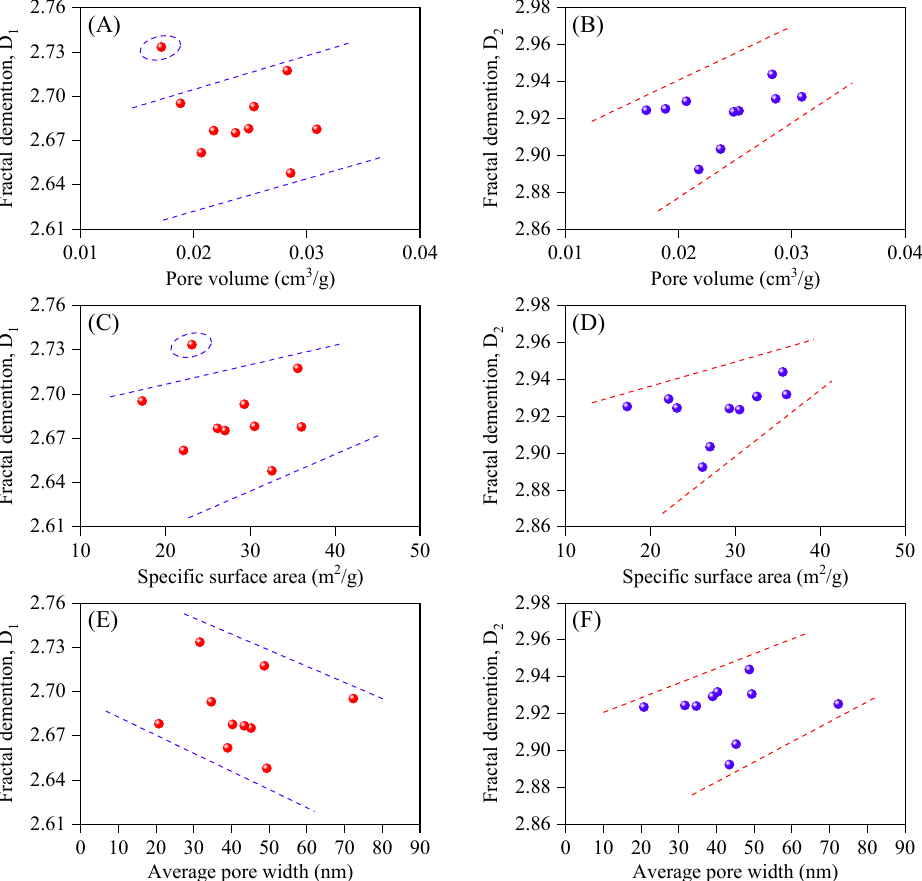
Figure 17. Relationships between fractal dimensions and PV ( A , B ), SSA ( C , D ), and average pore width ( E , F ).